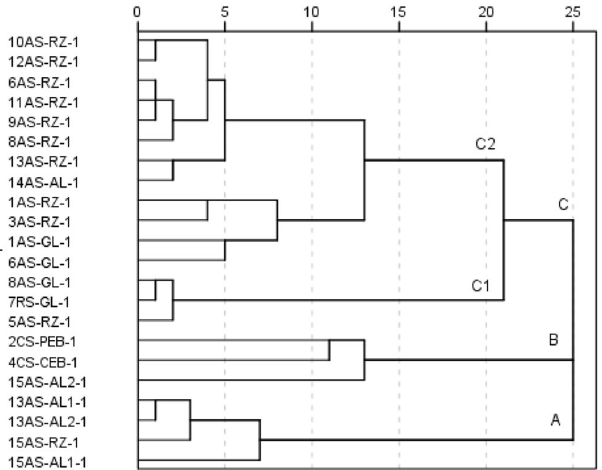
Figure 3. Dendrogram for hierarchical clustering of sites for the surface soil layer (Ward’s